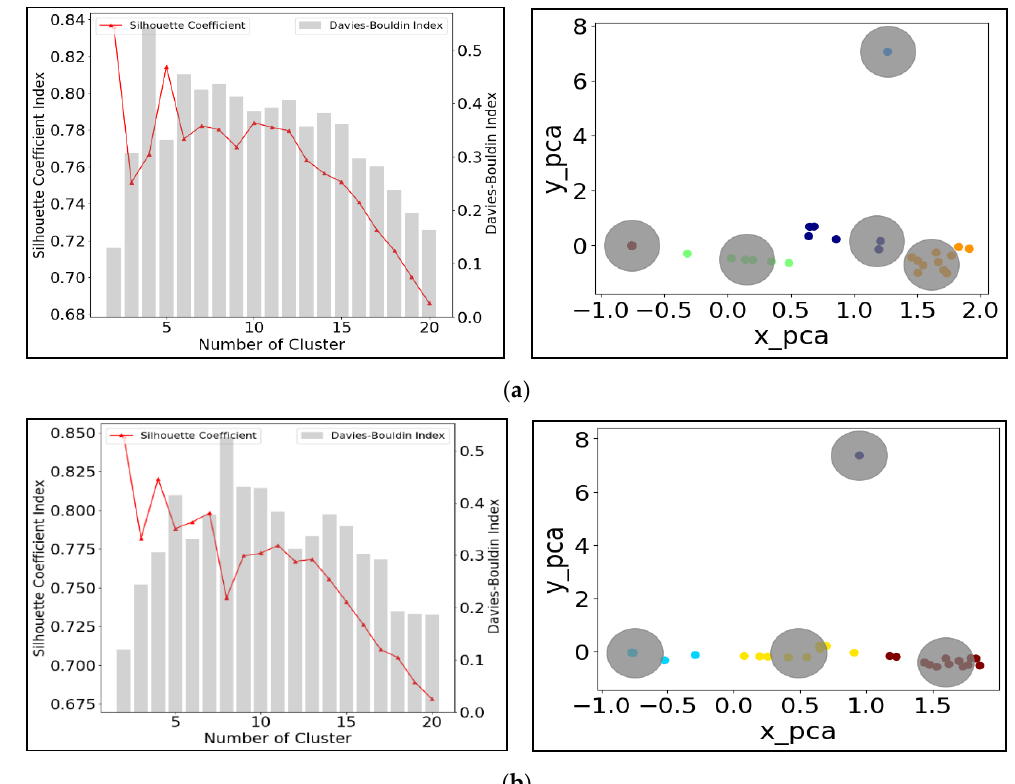
Figure 8. Cluster analysis test for time-series water depth generated by ( a ) 5 May 2015 flooding event; ( b ) 8 July 2015 flooding event (gray circles same to clusters), (x_pca means the first component score; y_pca means the second component score; The principal component scores are used to examine if these two clusters are reasonably distinguished from each other clustering).